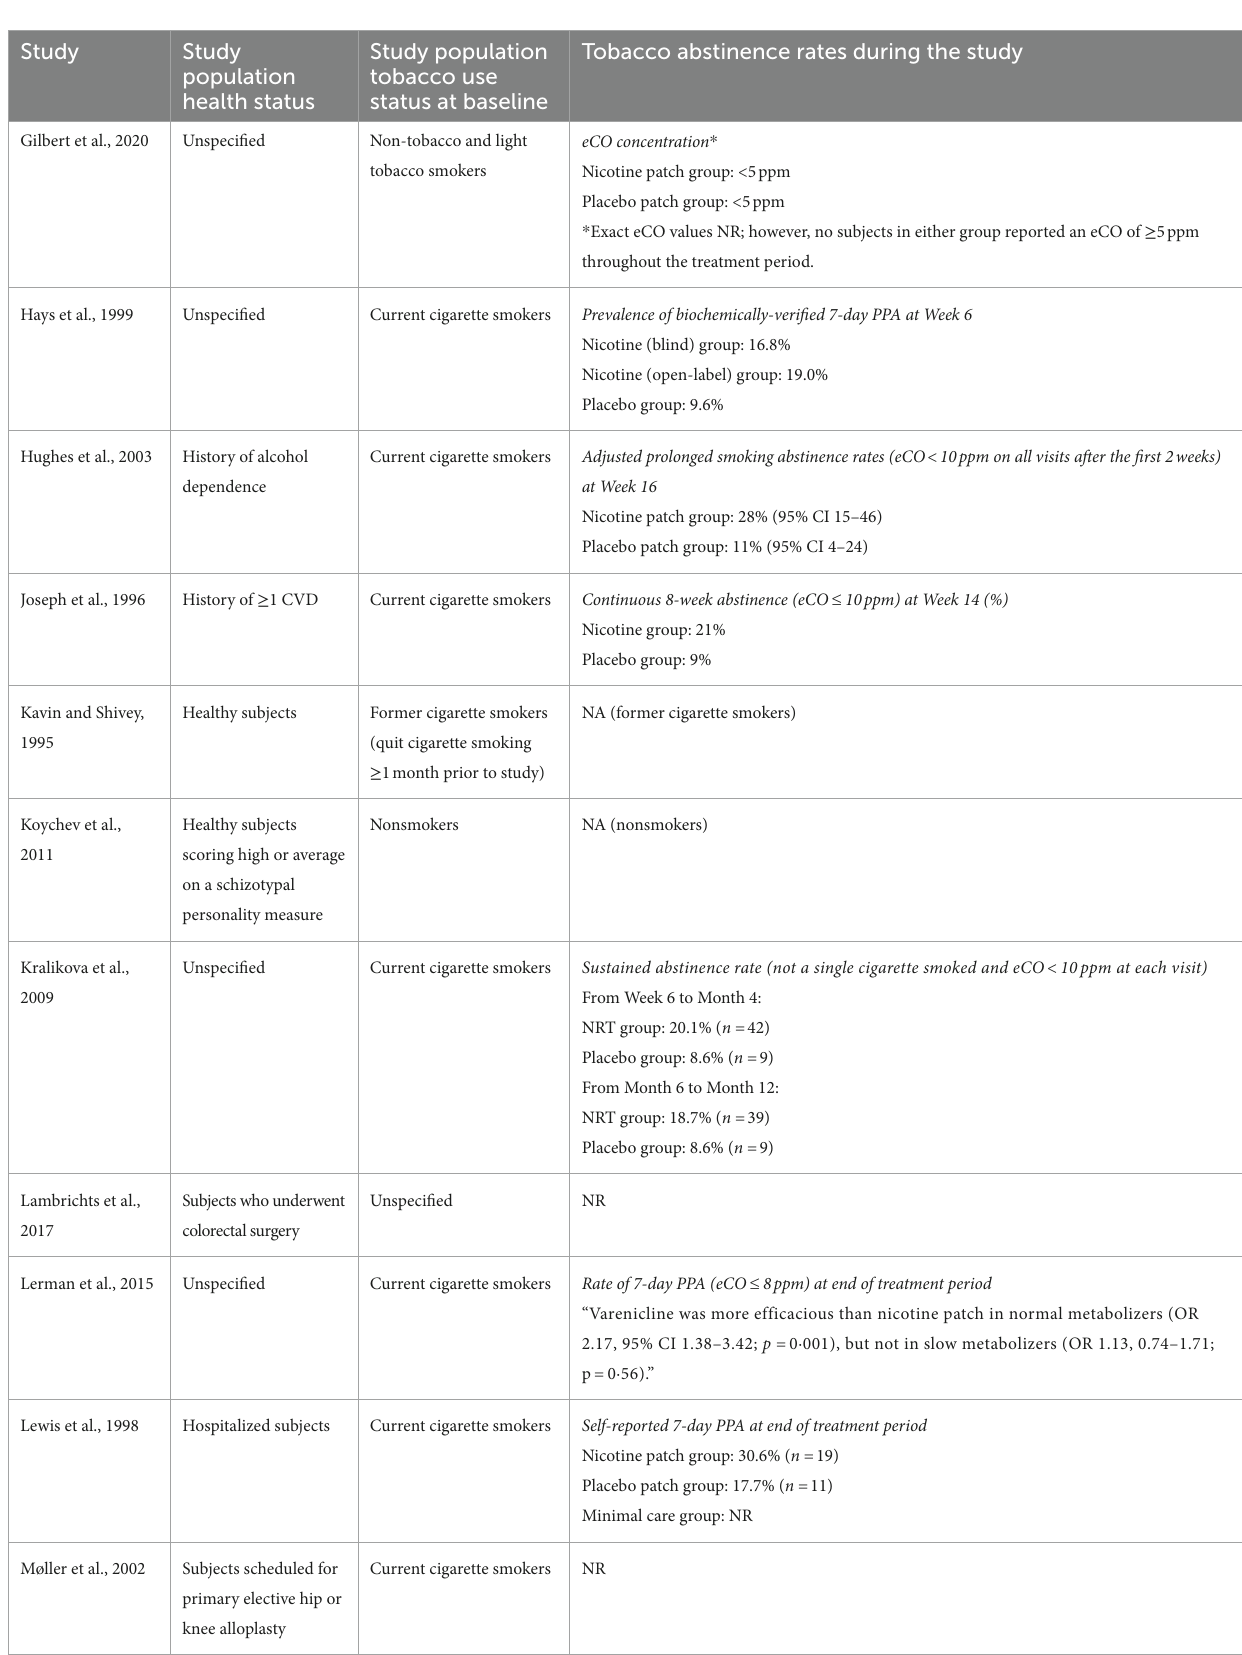
Placebo patch group: 17.7% ( n = 11) Minimal care group: